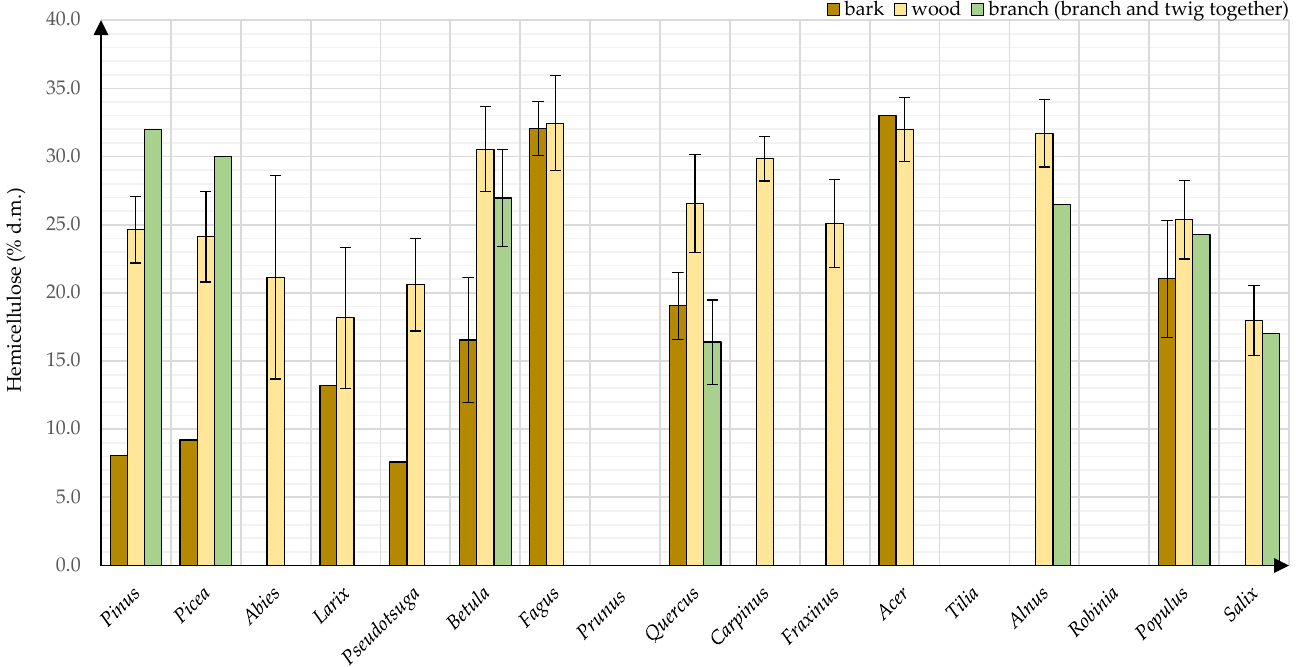
Figure 15. Average value and average deviation of the hemicellulose content of organs of particular systematic genera trees.